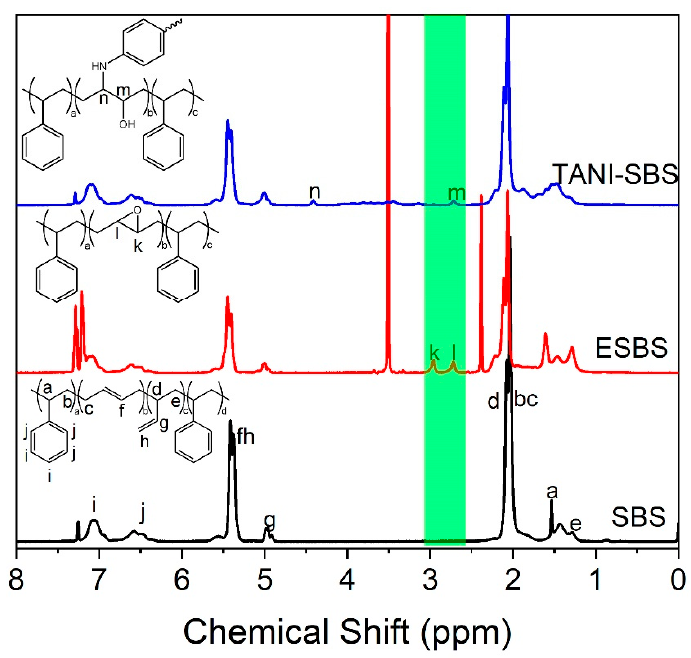
Figure 1. Protonic nuclear magnetic resonance ( 1 H NMR) spectra of styrene-butadiene-styrene (SBS), epoxidised SBS (ESBS) and TANI-SBS.